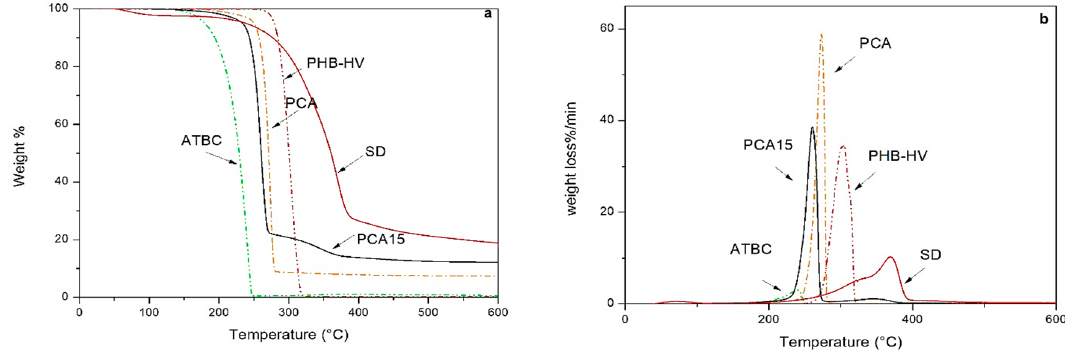
Table 1. Mechanical properties of the composites with different SD fiber contents.